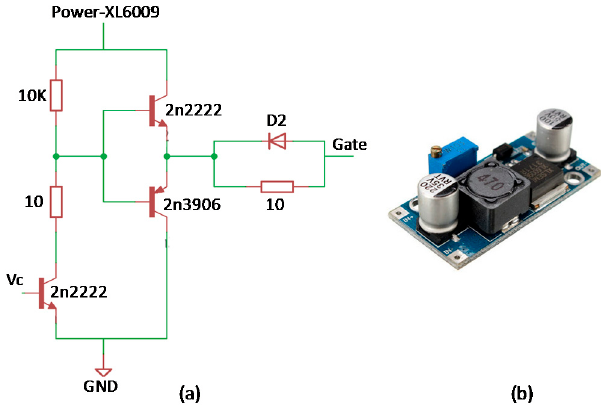
Figure 12. ( a ) Schematic diagram for totem pole driver; ( b ) XL6009 converter.